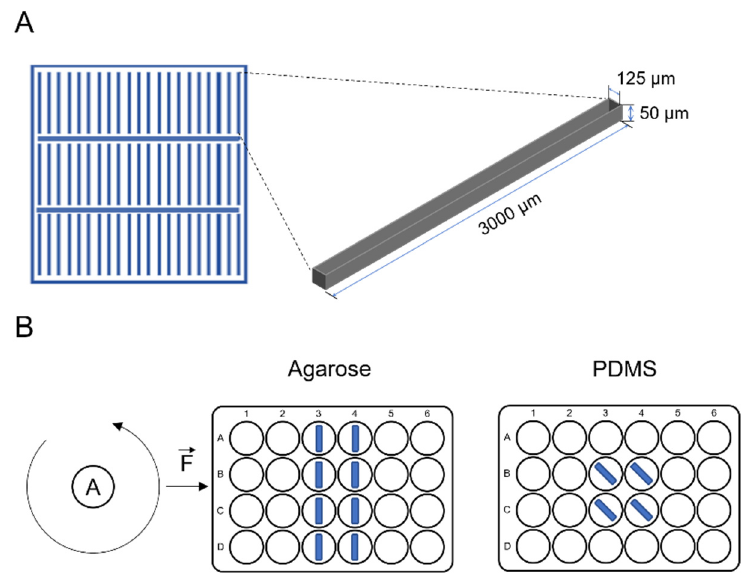
Figure 1. ( A ) Size, shape, and arrangement of the micropatterned mold used for tube formation. Each micropatterned mold holds three rows with 21 tube patterns. ( B ) Orientation of the tubes during the seeding process of forced gravity via centrifugation was established, as shown (F—centrifugal force, A—rotation axis).